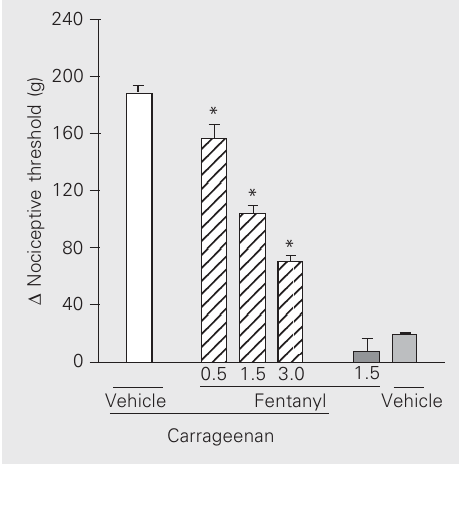
Figure 2. Exclusion of a central antinociceptive response to fen- tanyl. Fentanyl (µg) was admin- istered into the right (RP) or left (LP) paw 135 min after carra- geenan (Cg) administration into both hind paws. Each column indicates the mean ± SEM (N = 5). The symbols “–” and “+” indicate the absence and pres- ence of treatment, respectively. *P < 0.01 vs carrageenan + ve- hicle-injected control (ANOVA/ Bonferroni